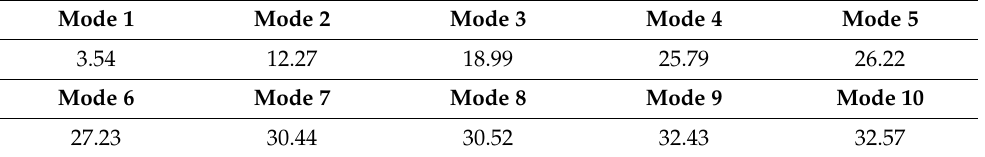
Table 7. Case 1: Values of the natural frequencies of vibrations, in Hertz- empty tank.